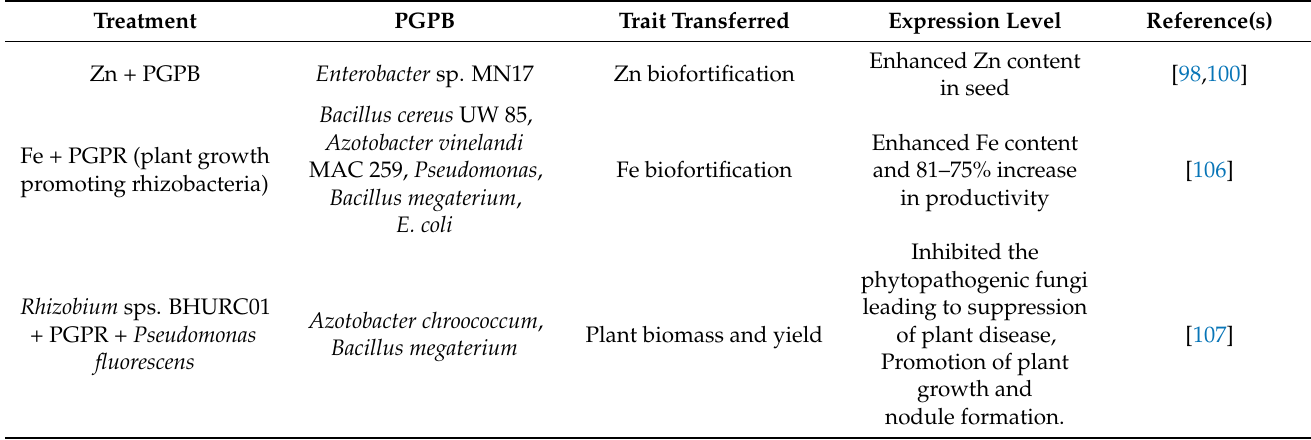
Table 5. Crop improvement of chickpea ( Cicer arietinum L.) by microbial